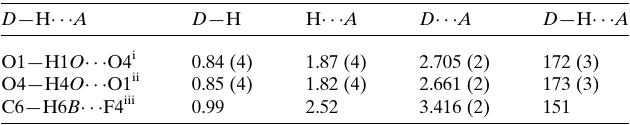
Table 1 Hydrogen-bond geometry (A˚ , (cid:4) ).